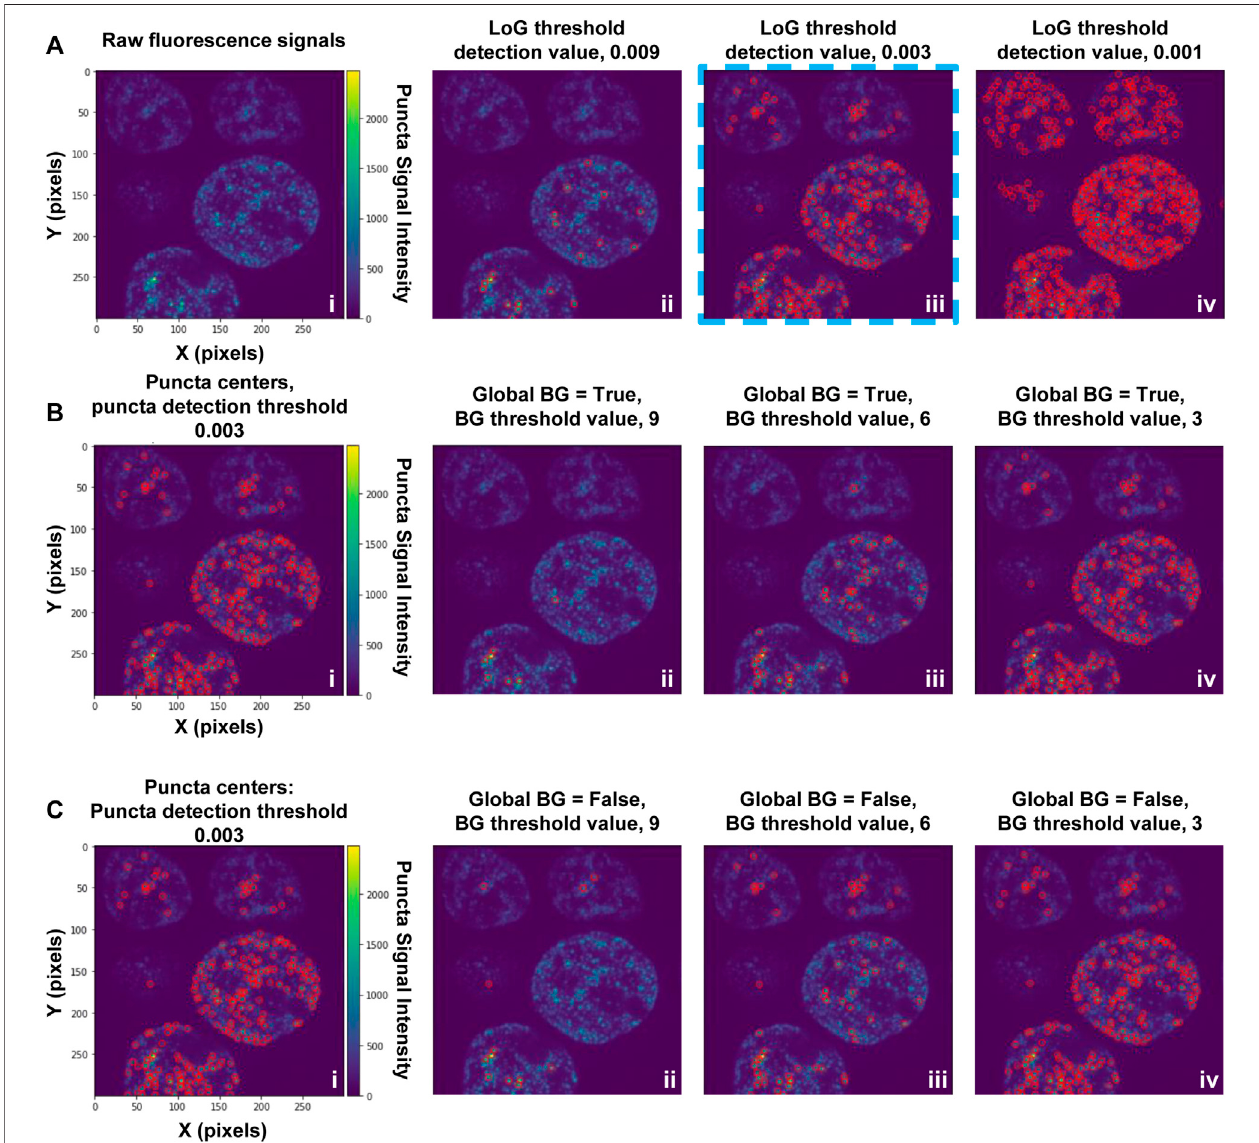
FIGURE 2 | Setting-up puncta centers detection. (A) Puncta in fl uorescence microscopy images are fi rst identi fi ed using a Laplacian of Gaussian (LoG) fi lter; the detectionsensitivityisdeterminedbytheLoG “ thresholddetection ” parameter.Punctacentersidenti fi edinanimagesubstackforcellsexpressingG-NHA9(i)usingthree settings of the LoG “ threshold_detection ” parameter are shown (ii – iv). Detection of puncta centers can be further re fi ned through adjustment of background fi ltering parameters, as illustrated in (B) and (C) . The examples in (B) and (C) used a LoG “ threshold detection ” value of 0.003, as shown in (A) , panel iii (blue dashed box). These data are also shown on the left (i) in panels (B) and (C) . In (B) puncta centers were identi fi ed using the Global Background (BG) = “ True ” option, and a range of valuesofthebackground(BG)thresholdparameter(ii – iv).In (C) ,punctacenterswereidenti fi edusingtheGlobalBackground(BG)= “ False ” option,andarangeofvalues of the background threshold parameter (ii-iv). With the Global Background (BG) = “ True ” option (B) , a fi xed background threshold is applied to all ROI (cell nuclei) in the image, while with the “ False ” option (C) , the background threshold value is calculated for each ROI (cell nucleus)